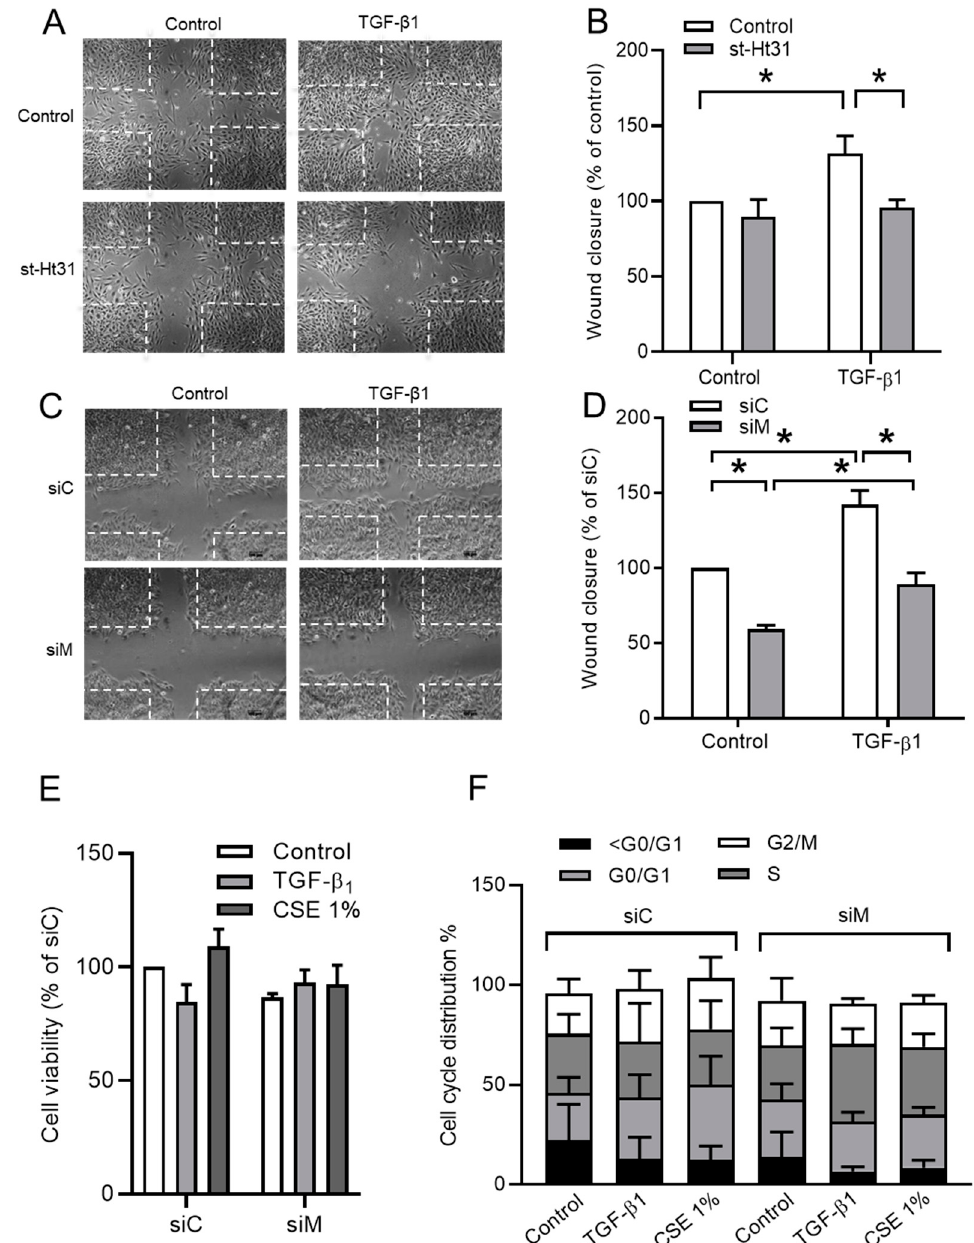
Figure 6. Role of AKAPs—Ezrin, AKAP95, and Yotiao—in TGF- β 1-induced cell migration using BEAS-2B cells. ( A ) Representative images of wound healing assay of BEAS-2B cells after 24 h post scratch. The white dotted line indicated borders of scratches at 0 h. ( B ) Quantification of wound closure of cells pre-incubated with 50 µ M st-Ht31 for 30 min., following stimulated with 3 ng / mL TGF- β 1 for 24 h. ( C ) Representative images of wound healing assay of BEAS-2B cells after 24 h post scratch. The white dotted line indicated borders of scratches at 0 h. ( D ) Quantification of wound closure of TGF- β 1 treated cells icombined knockdown of Ezrin, AKAP95, and Yotiao. ( E ) 3-(4,5-dimethylthiazol-2-yl)-2,5-diphenyltetrazolium bromide (MTT) assay in BEAS-2B cells that were transfected with a combination siRNA of Ezrin, AKAP95, and Yotiao together with 3 ng / mL TGF- β 1 and 1% CSE exposure. ( F ) Cell cycle distribution in BEAS-2B cells that were transfected with a combination siRNA of Ezrin, AKAP95, and Yotiao together with 3 ng / mL TGF- β 1 and 1% CSE exposure. The data represent 3–5 independent experiments. Data are expressed as mean ± SEM, * p < 0.05; significant difference between indicated groups.